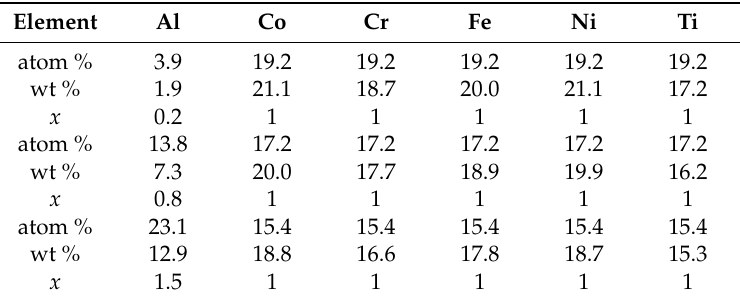
Table 1. Target composition of the three alloys.